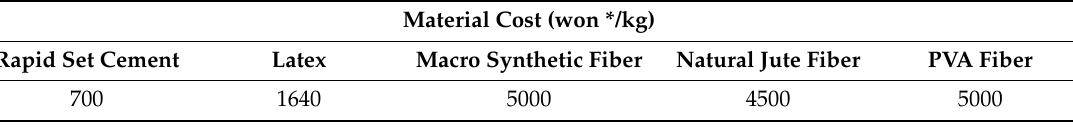
Table 7. Costs of materials (provided by manufacturer).